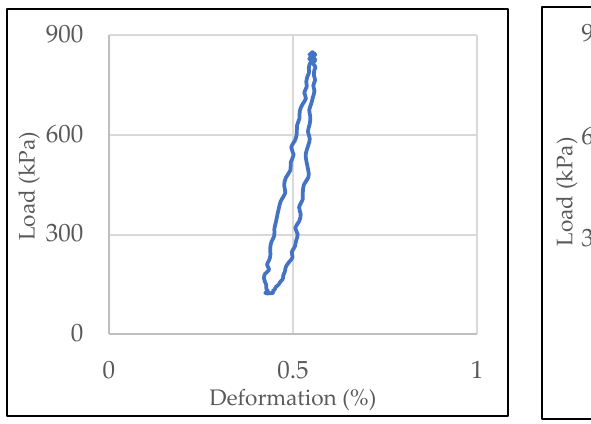
Figure 7. Elastic hysteresis loops of mixtures with modified bitumen CRM-10: ( a ) SMA8 LA (30% RG), ( b ) SMA8 LA (20% RG), ( c ) SMA8 LA (10% RG), ( d ) SMA8 LA.